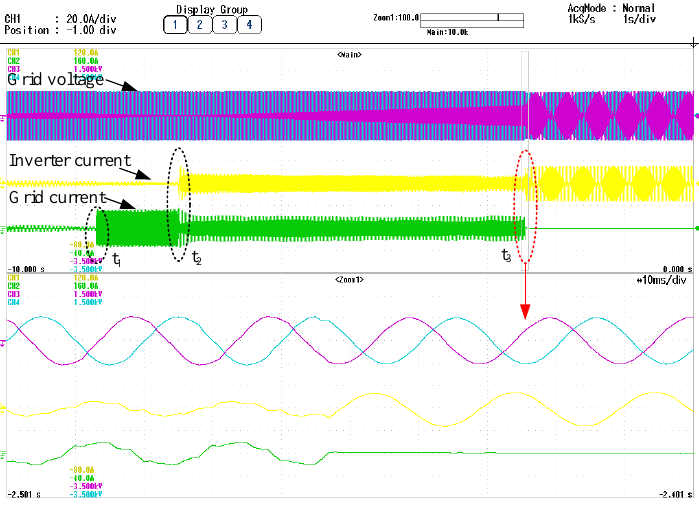
Figure 28. Grid-connection and off-grid switchover